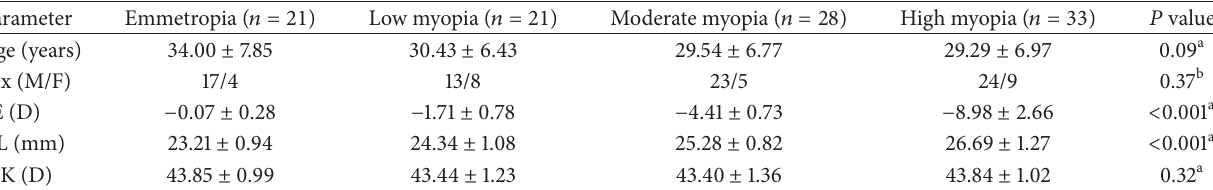
Table 1: The demographic data of the study